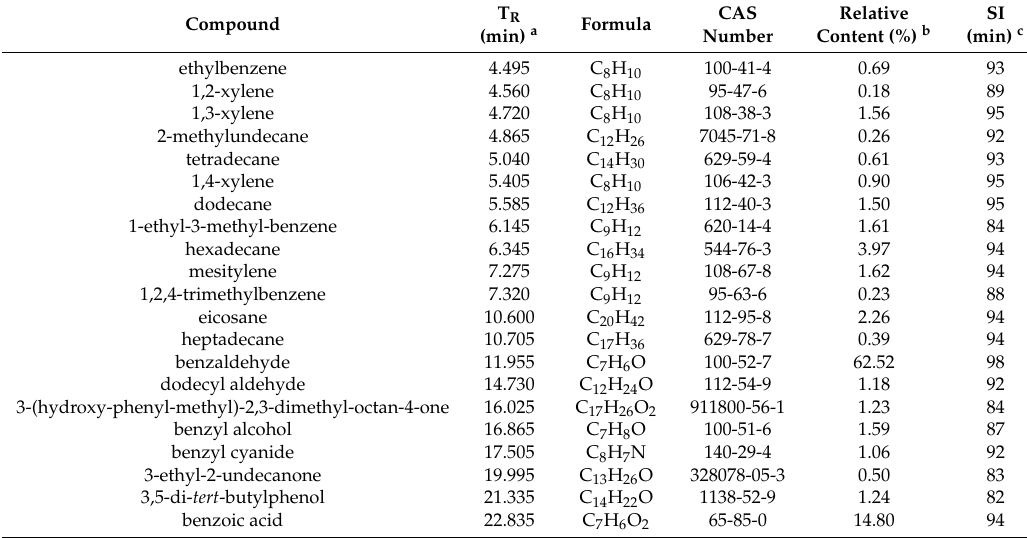
Table 1. Identification of the chemical composition of bitter almond essential oil (BAEO) by chromatography–mass spectrometry